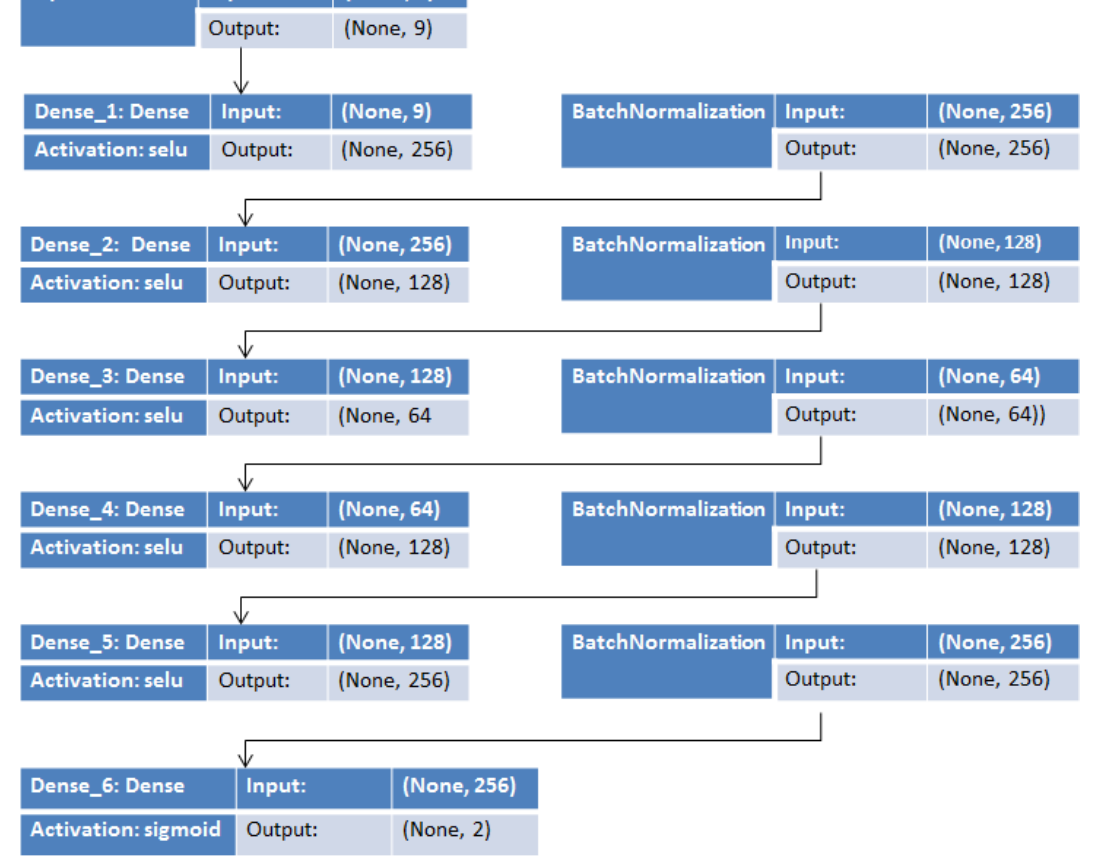
Figure 12. The best-suited regression-based deep neural network MLP model.